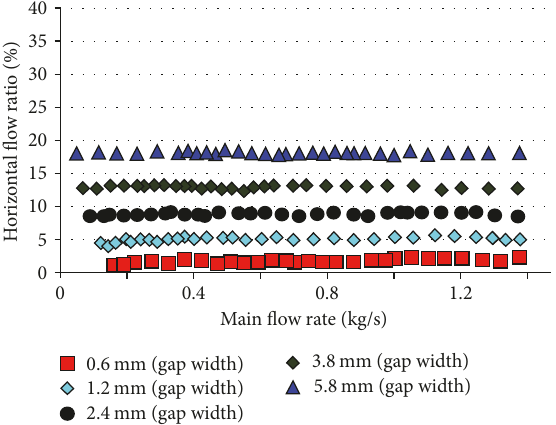
Figure 3: Horizontal flow ratio versus main flow rate.